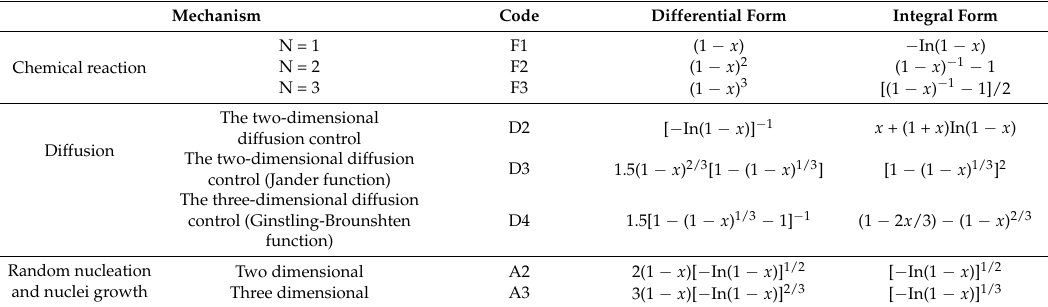
Table 6. The common mechanism functions in pyrolysis reactions.